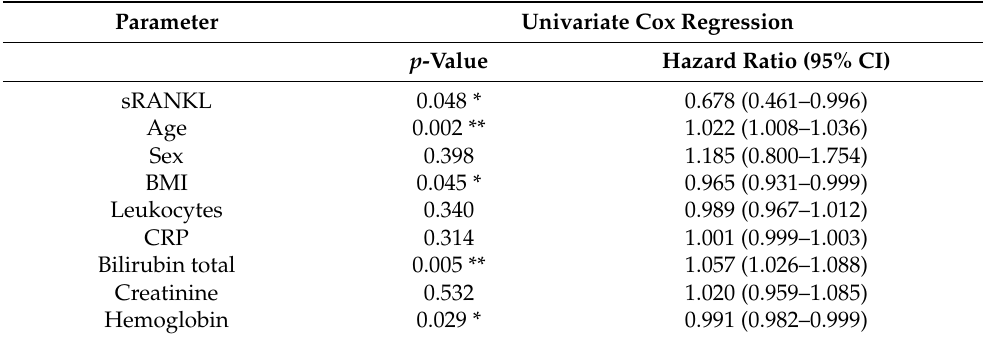
Figure 4. Prediction of ICU and long-term mortality by sRANKL serum levels. ( A ) sRANKL serum levels at ICU admission did not correlate with ICU survival but predict a poor overall survival in the long-term (three years of follow-up). ( B ) Kaplan–Meier survival curves of critically ill patients are displayed for the three years of follow-up demonstrating that patients with sRANKL serum levels below a cut-off value of 0.015 pmol/L had a higher probability of long-term mortality. ( C ) ROC curve analysis reveals that sRANKL serum concentrations at an optimal predictive cut-off value for long-term survival (0.015 pmol/L) at admission to ICU had an AUC value of 0.567 regarding discrimination between 3 years survival and 3 years death. All data are shown as available. * p < 0.05, n.s.: not significant. Table 4. Univariate Cox-regression analysis of sRANKL serum concentrations in critically ill